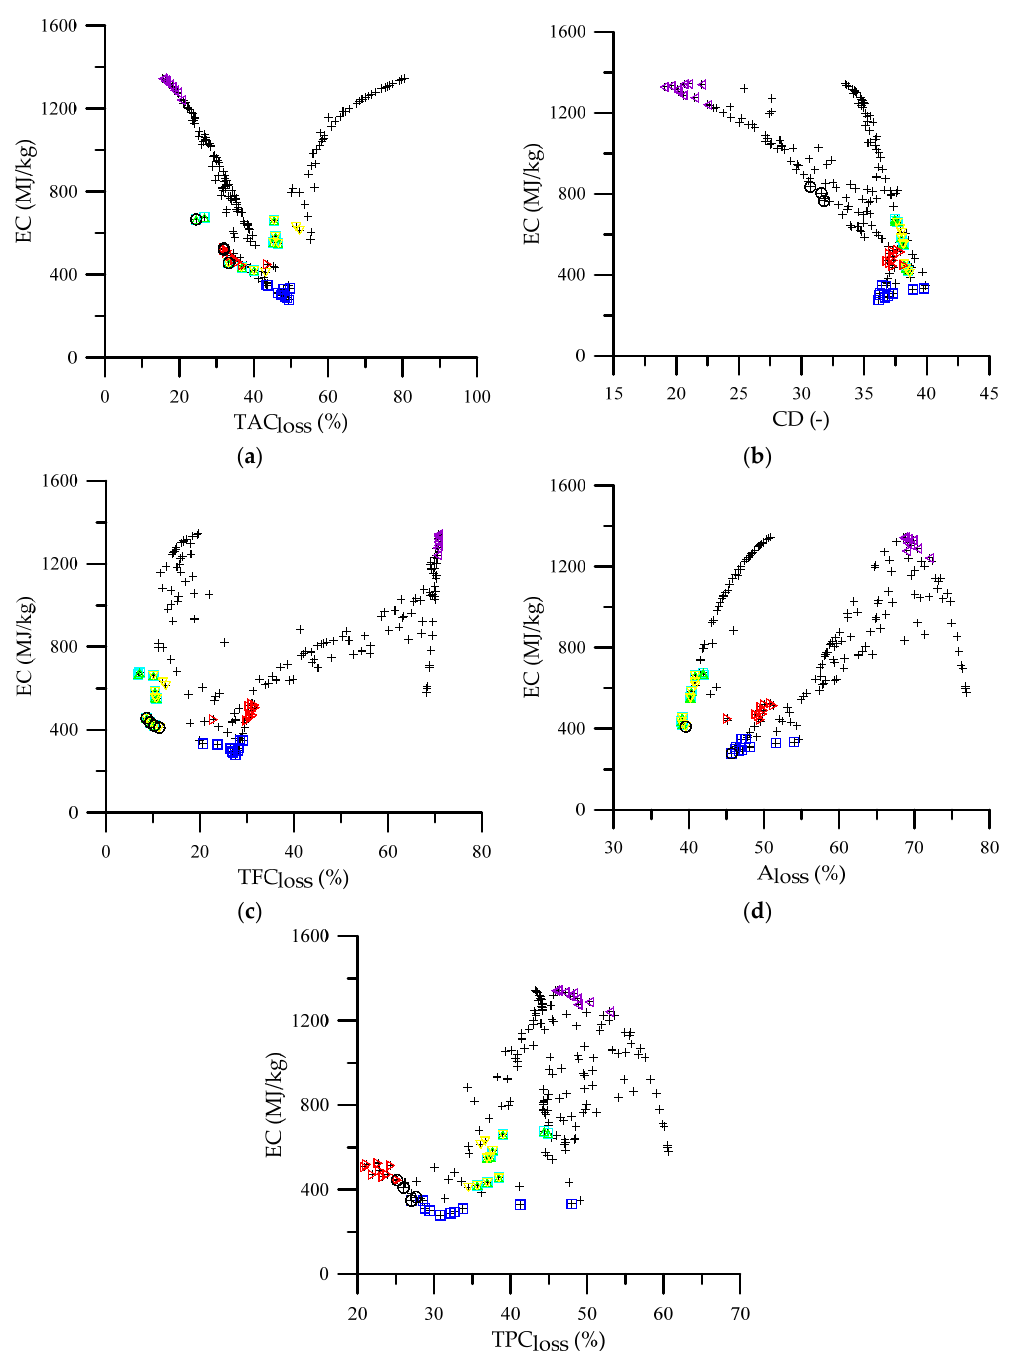
Figure 4. Pareto fronts-two-dimensional views: ( a ) EC-TAC loss , ( b ) EC-CD, ( c ) EC-TFC loss , ( d ) EC-A loss , ( e ) EC-TPC loss ; O–the best solutions, +—data, ■ —EC min , ■ —TAC loss min , ▲ —TFC loss min , ▼ —A loss min , ► —TPC loss min , ◄ —CD min .